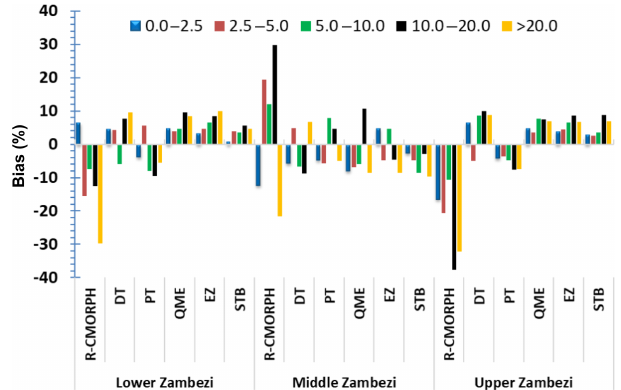
Figure 9. Bias correction (%) for the respective rainfall rate (mmd − 1 )